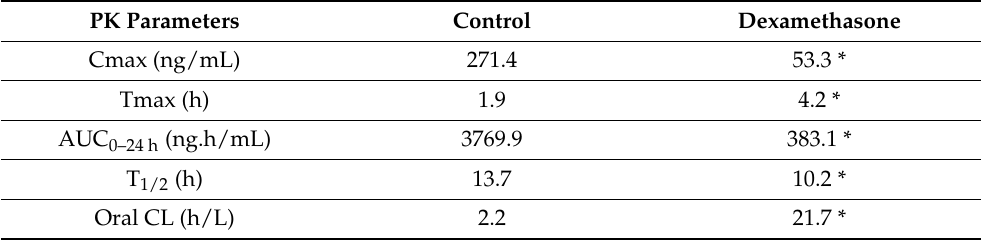
Figure 3. Serum concentration-time curves of abiraterone acetate (180 mg/kg) following a single oral administration to adult male CD-1 mice ( n = 3) in the presence or absence (vehicle) of intraperitoneal dexamethasone (80 mg/kg/day). Data are expressed as mean ± SEM (n of 3 for each time point). Table 1. Pharmacokinetic parameters of abiraterone following a single oral dose of abiraterone acetate (180 mg/kg) administered to adult male CD-1 mice ( n = 3) in the presence or absence (vehicle) of intraperitoneal dexamethasone (80 mg/kg/day).